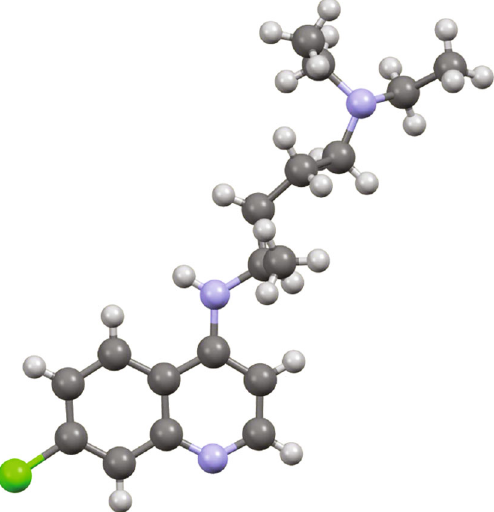
Figure 3: Molecular structure of chloroquine.